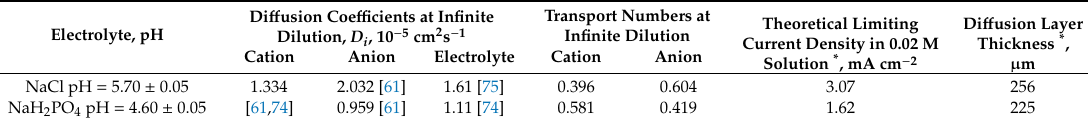
Table 1. Several characteristics of the electrolyte solutions and membrane systems under study. The data are related to the temperature, 25 ◦